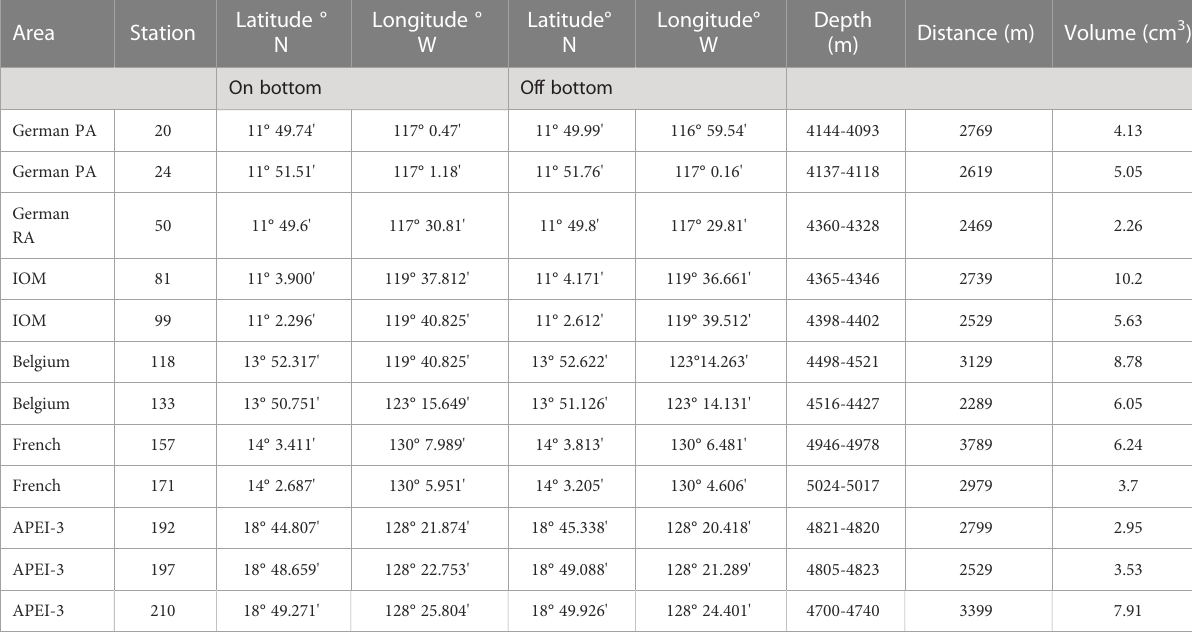
TABLE 1 Station data, based on Table 7.2.6.7 in Mart ı ́ nez Arbizu and Haeckel